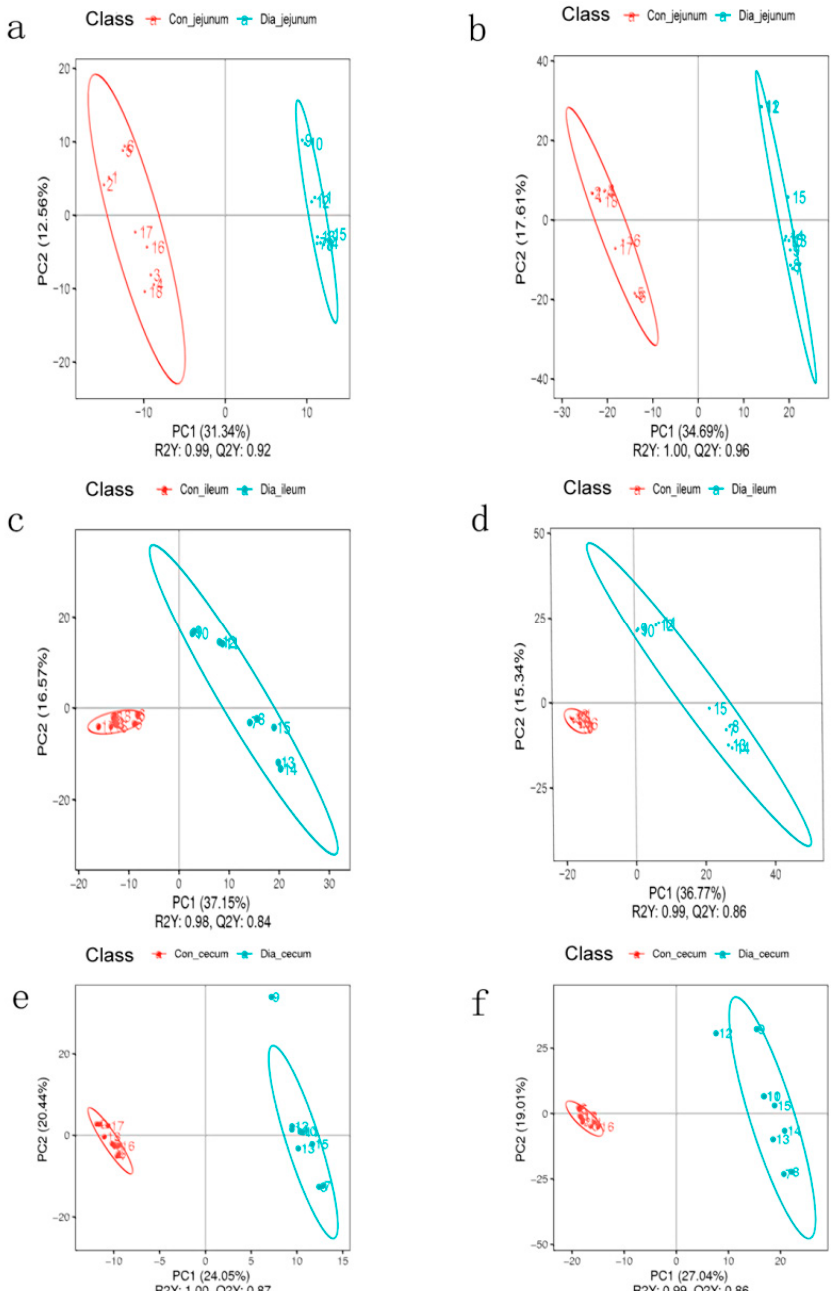
Figure 2. Partial least squares discriminant analysis (PLS − DA) was used to evaluate the sample differences between groups. ( a , b ) PLS − DA score map of jejunum in normal and diarrhea group under positive and negative ion modes; ( c , d ) PLS − DA score map of ileum in normal and diarrhea group under positive and negative ion modes; ( e , f ) PLS − DA score chart in positive and negative ion modes of cecum in normal and diarrhea groups.